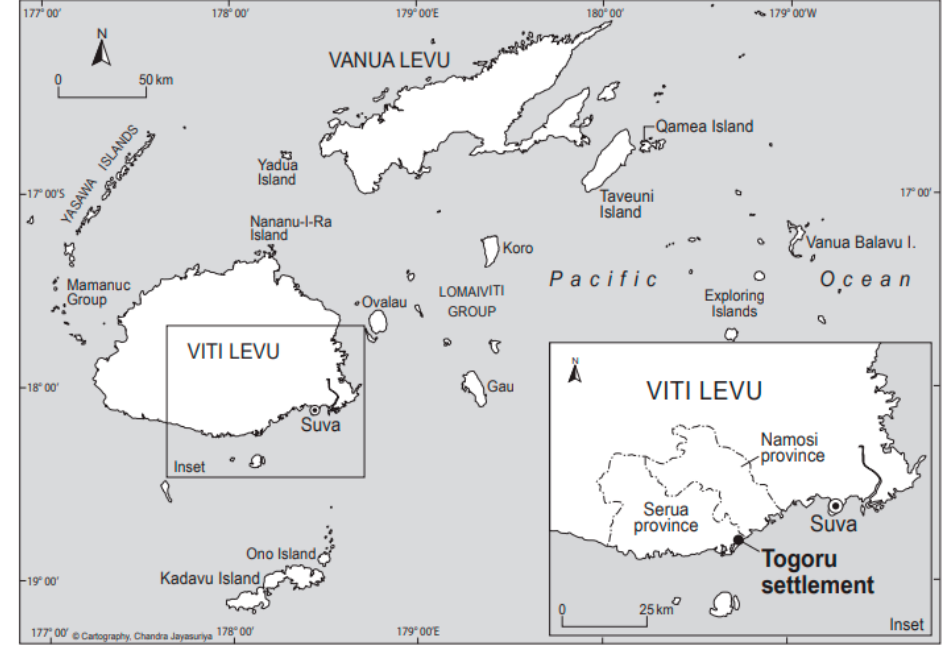
Figure 2. Map of Fiji showing the location of Togoru (prepared by Chandra Jayasuriya).